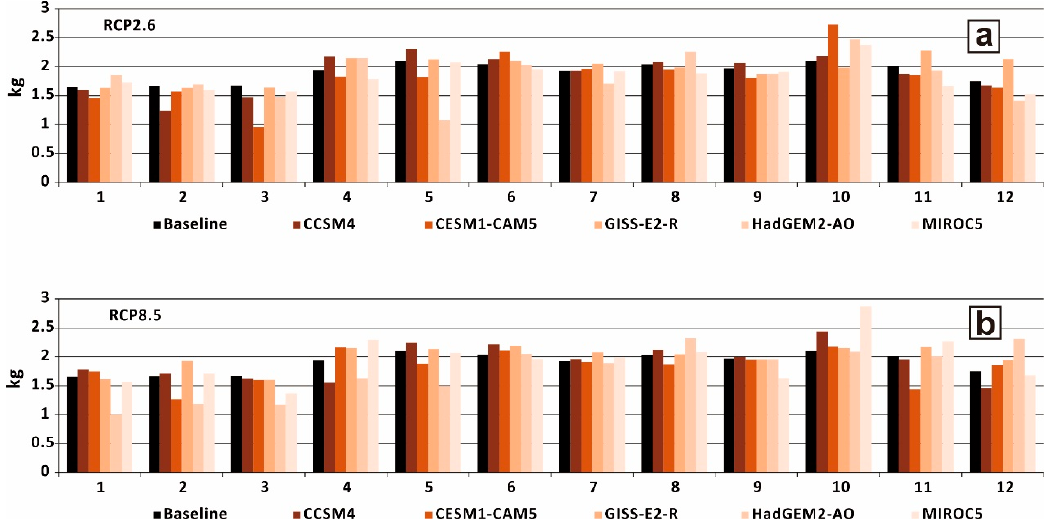
Figure 7. The average monthly P export under different climate change scenarios ( a ) RCP2.6 and ( b ) RCP8.5. Note: Numbered months along x-axis.